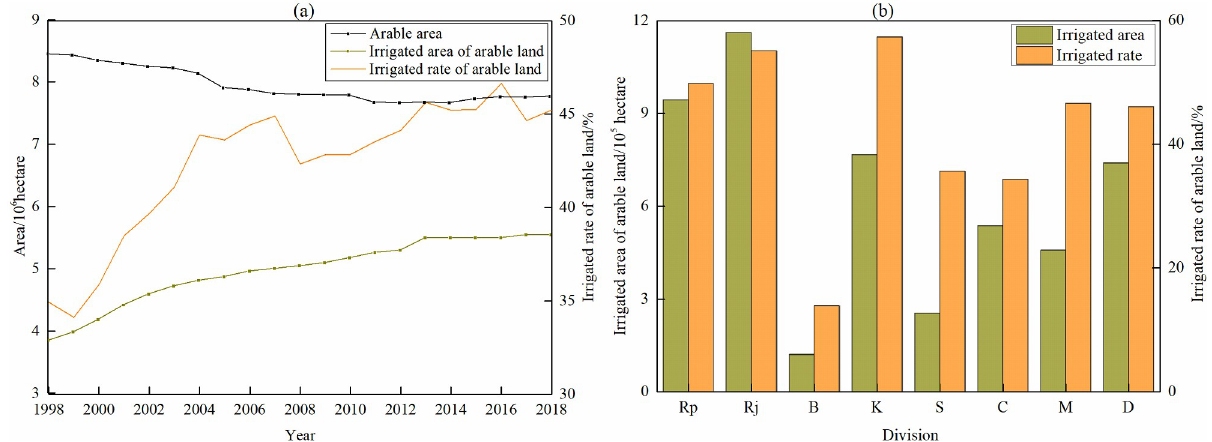
Fig 9. Irrigation change in Bangladesh. (a) Irrigation rate in Bangladesh from 1998 to 2018, (b) Average of irrigation of eight divisions. (Rp: Rangpur, Rj: Rajshahi, B: Barisal, K: Khulna, S: Sylhet, C: Chittagong, M: Mymensingh, D: Dhaka).